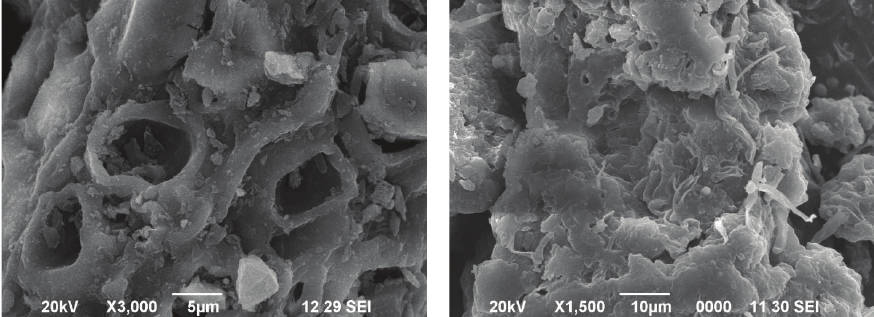
Figure 3: SEM images of TGAN and TGAN-Ni.